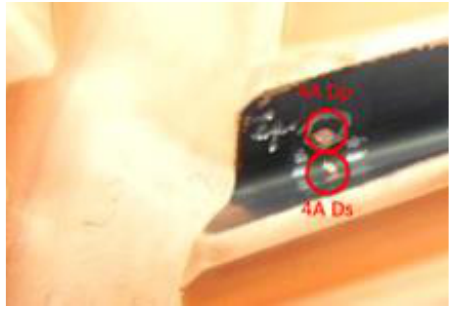
Figure 6. Gear sample with copper “spots” varying in size, representing chips in different locations on the gear teeth.